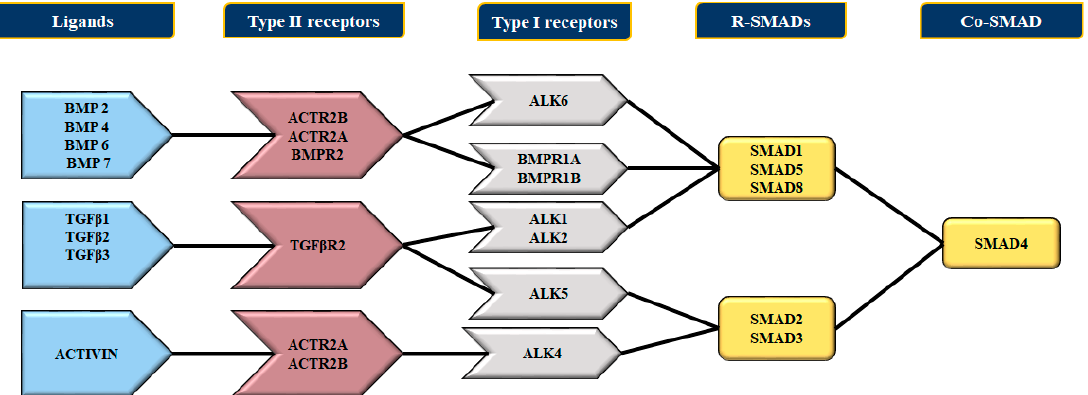
Figure 4. Diagrammatic representation portraying the correlation of BMP ligands, type II and type I receptors, and the SMAD proteins during signal transduction. Regarding the binding of BMPs to type I receptors, BMP ‐ 2 and BMP ‐ 4 bind to BMPR ‐ IB receptors. BMP ‐ 6 and BMP ‐ 7 bind robustly to ALK ‐ 2 receptors and less strongly to BMPR ‐ IB receptors; BMP ‐ 9 and BMP ‐ 10 bind to ALK ‐ 1 and ALK ‐ 2, respectively. Similarly, the ALKs are classified depending on their structural and functional morphology and role. The ALK1 group comprises ALK1 and ALK2, whereas the BMPR1 group comprises BMPR1A/ALK3 and BMPR1B/ALK6. The receptors of the ALK1 group and BMPR1 group phosphorylate SMADSs 1/5/8, while the TGF ‐β RI group phosphorylates SMADs 2/3. The type II receptors are BMPR2 activin receptor 2A (ACTR2A) and 2B (ACTR2B). The BMPR2 exclusively binds BMPs, while ACTR2A and ACTR2B can bind to activin, myostatin, and BMPs. Type II receptors bind most BMP ligands and interfere with the binding of BMPs to type I receptors.